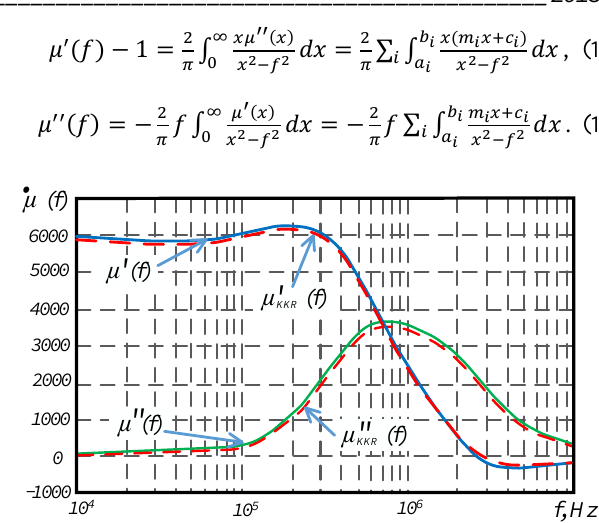
Fig. 2. KKR application to EPCOS MnZn TDK-37 ferrite sample